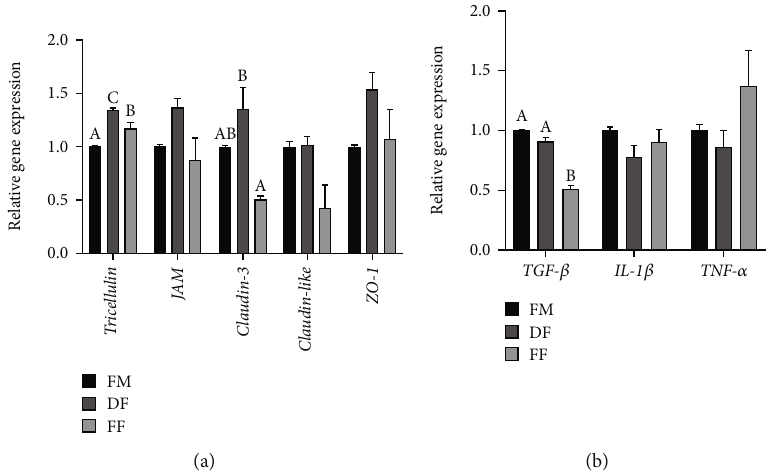
Figure 7: The gene expression of mechanical barrier (a) and immunologic barrier (b) in distal intestine of experimental turbot. The di ff erent letters on the bar chart represent signi fi cant di ff erences in the mean values ( n = 6 ) between the groups ( P < 0 : 05